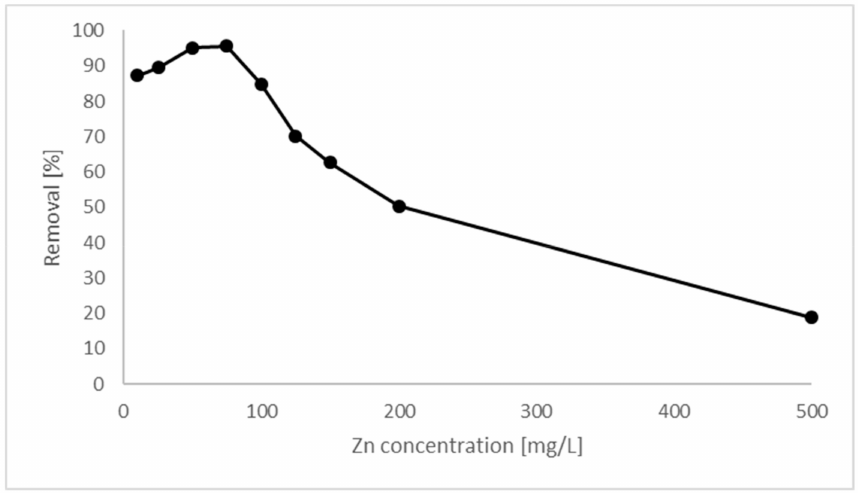
Figure 2. Removal percentages as a function of Zn initial concentration. Experiments were done duplicated and the removal % varied in the range of 3 percentage